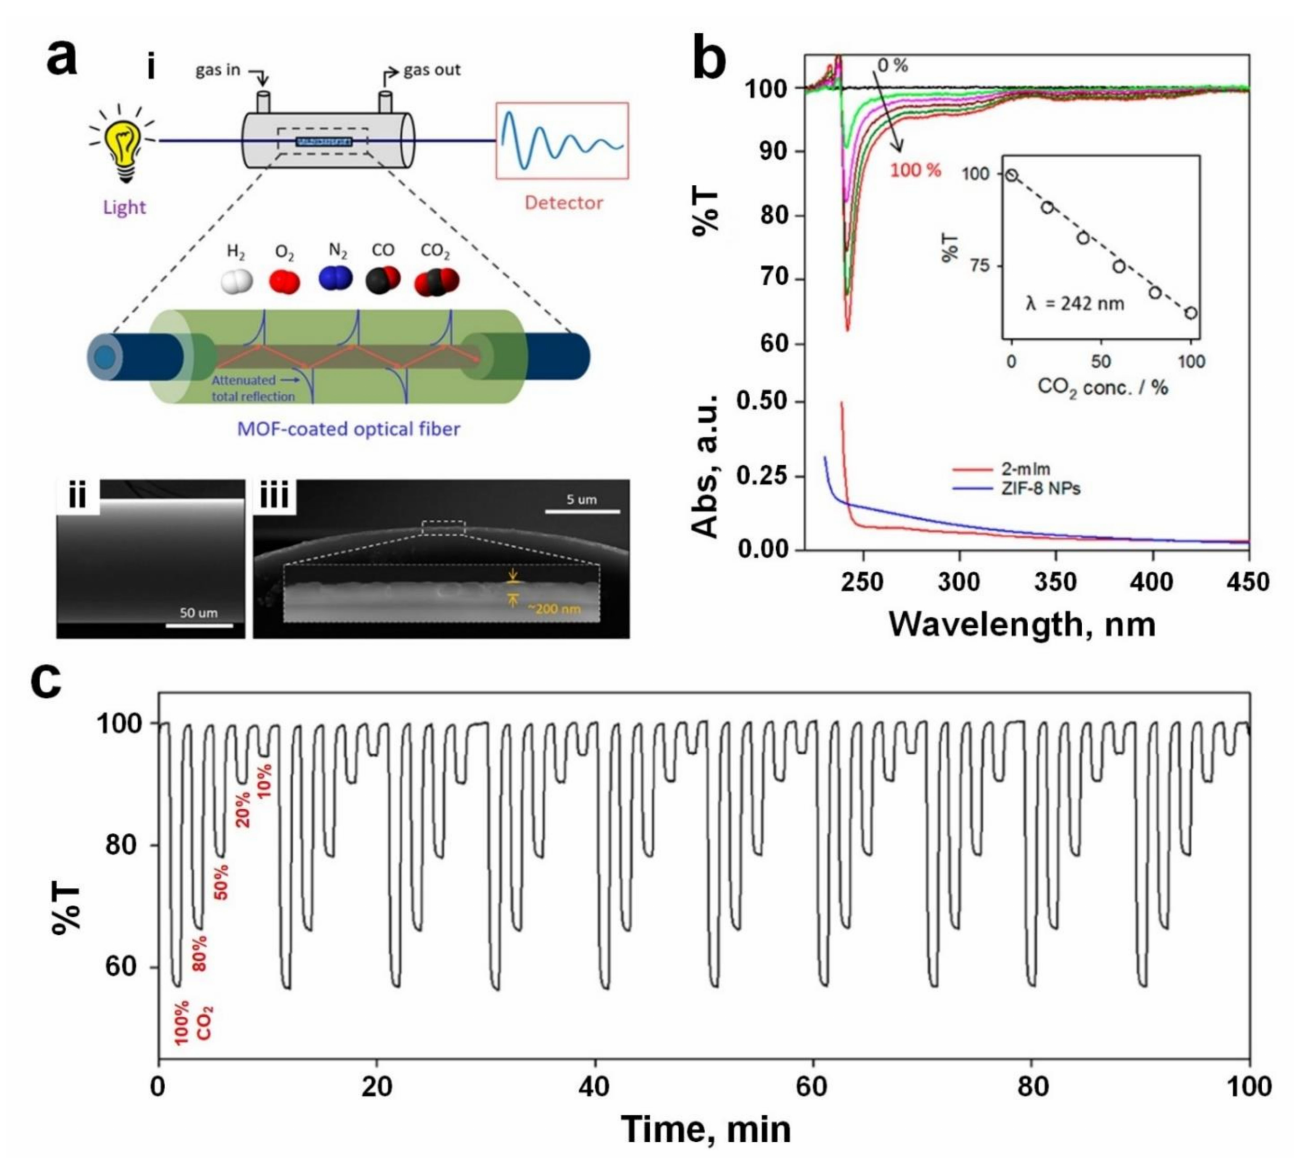
Figure 8. ( a (i)) Graphic representation of the gas detection system using MOF-coated optical fiber. FESEM images of top ( a (ii)) and side ( a (iii)) views of optical fiber covered by 200 nm thick ZIF-8. ( b ) The transmittance spectra of 350 nm thick ZIF-8 coated optical fiber against varied CO 2 levels, and the absorbance spectra of 2-mIm and ZIF-8. A linearity of %T ( λ = 242 nm) and CO 2 concentrations was plotted as inset. ( c ) Ten cyclic dynamic responses of 200 nm thick ZIF-8 coated optical fiber under different CO 2 concentrations. Reproduced with permission from [103] American Chemical Society,